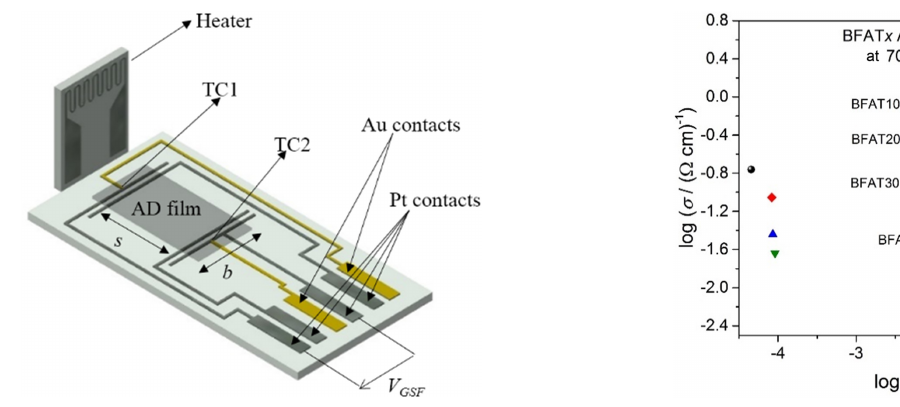
Figure 1. Sketch of the transducer and measurement setup. Figure 2. Double logarithmic representation of the electrical con- ductivity ( σ ) vs. the oxygen partial pressure ( p O 2 ) of BFAT x AD thick films at 700 ◦ C.